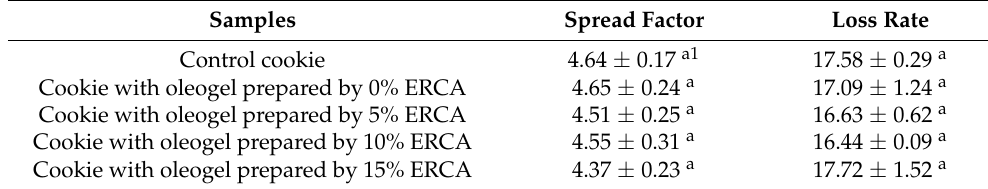
Table 3. Spread factor and loss rate of control cookie and cookie with oleogel prepared by different concentrations of esterified rice flour with citric acid (ERCA; 0, 5, 10, and 15%, respectively).